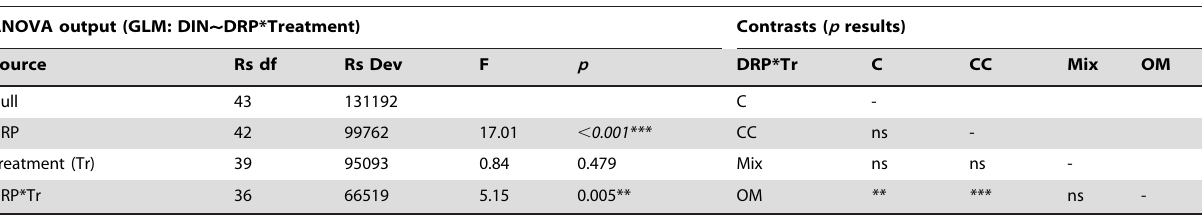
Table 3. ANOVA output from the GLM Model 2b (Gaussian distribution, identity link function) indicating the significance of dissolved reactive phosphorus (DRP) on dissolved inorganic nitrogen (DIN) among treatments (OM: Organic matter, CC: Calcium carbonate, Mix: OM + CC, and C: